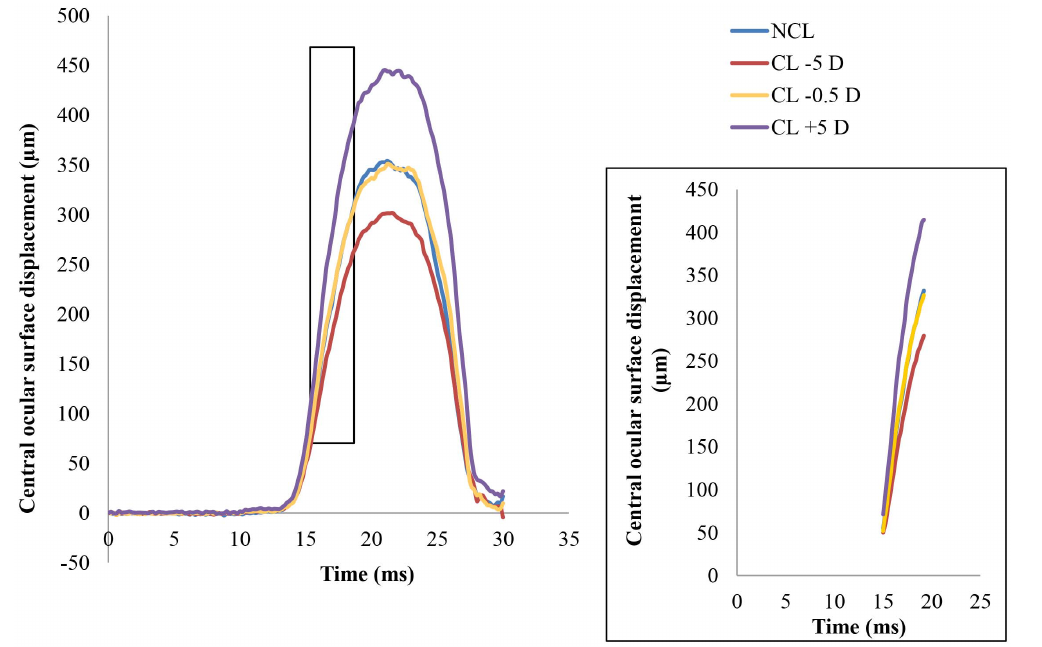
Figure 1. The average of central ocular surface displacement of subjects. Contact lens use changes the amount of ocular surface displacement. doi:10.1371/journal.pone.0096066.g001 PLOS ONE |